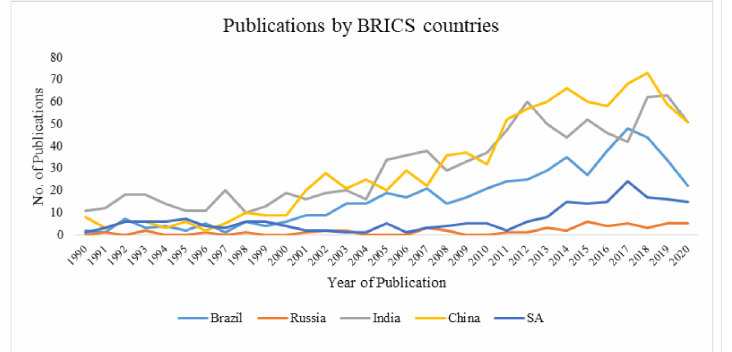
Figure 1. Comparison of publications by BRICS versus non-BRICS countries (1990–2020).